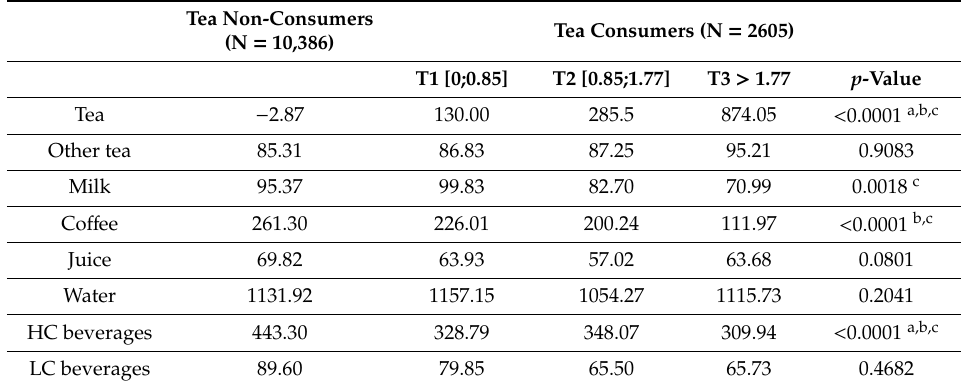
Table 2. Beverage consumption among adults (g / day) by tea consumption status. Non-consumers (NC) are compared to consumers split by tertiles (T1, T2, and T3) of tea consumption (Least square